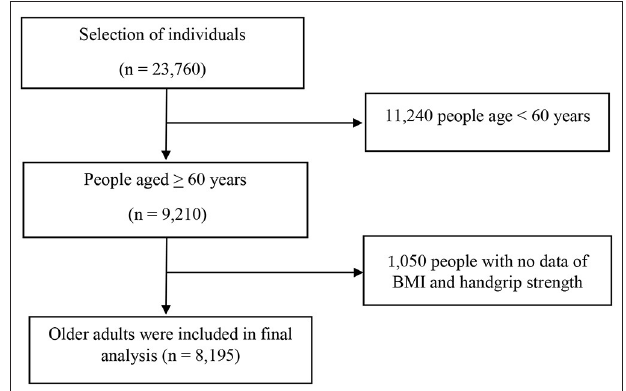
FIGURE 1 | The flowchart of participants’ selection